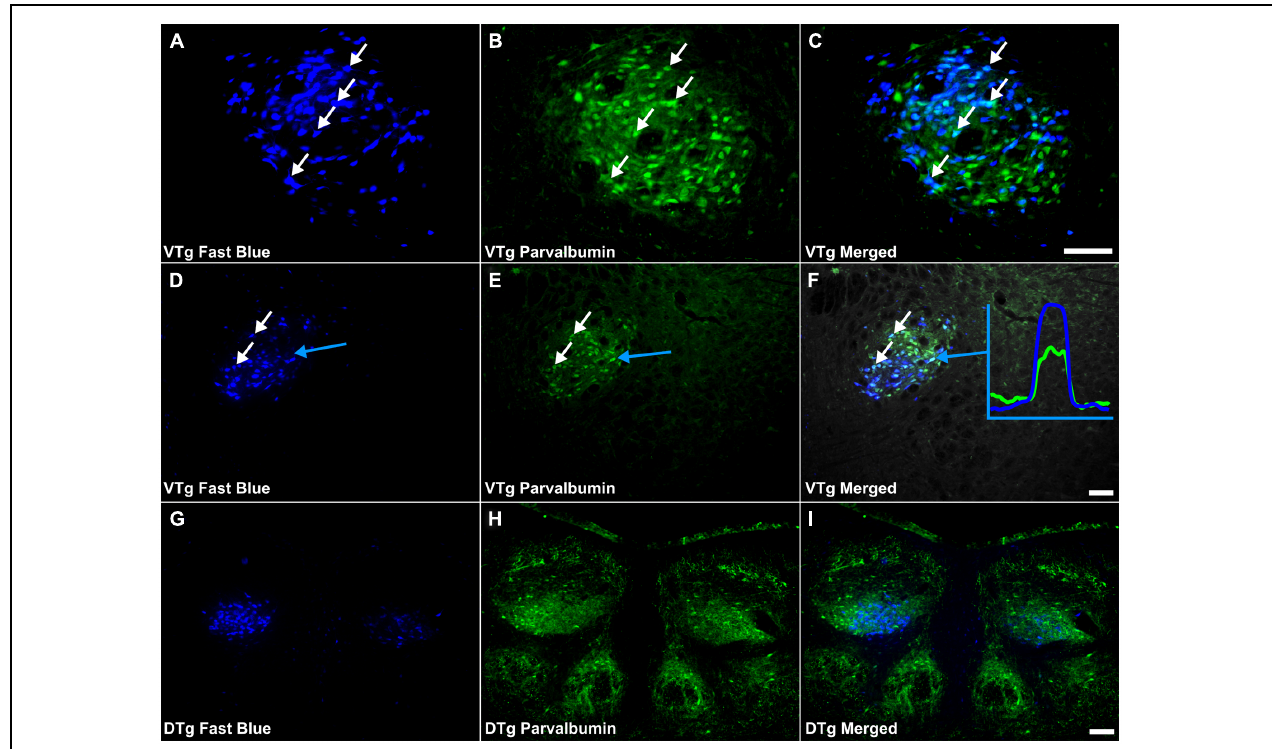
FIGURE 5 | Parvalbumin/Gudden’s tegmental nuclei: (A,D,G) Fluorescent photomicrographs showing retrogradely labeled Fast Blue cells in the rostral VTg, more caudal (D) parts of VTg and in the DTg (G), respectively. (B,E,F) show fluorescent PV immunoreactivity in respective sections while (C,F,I) show retrograde Fast Blue label and PV immunoreactivity superimposed. White arrows in (A–C) and (D–E) identify examples of individual retrogradely Fast Blue labeled cells (A,D) that